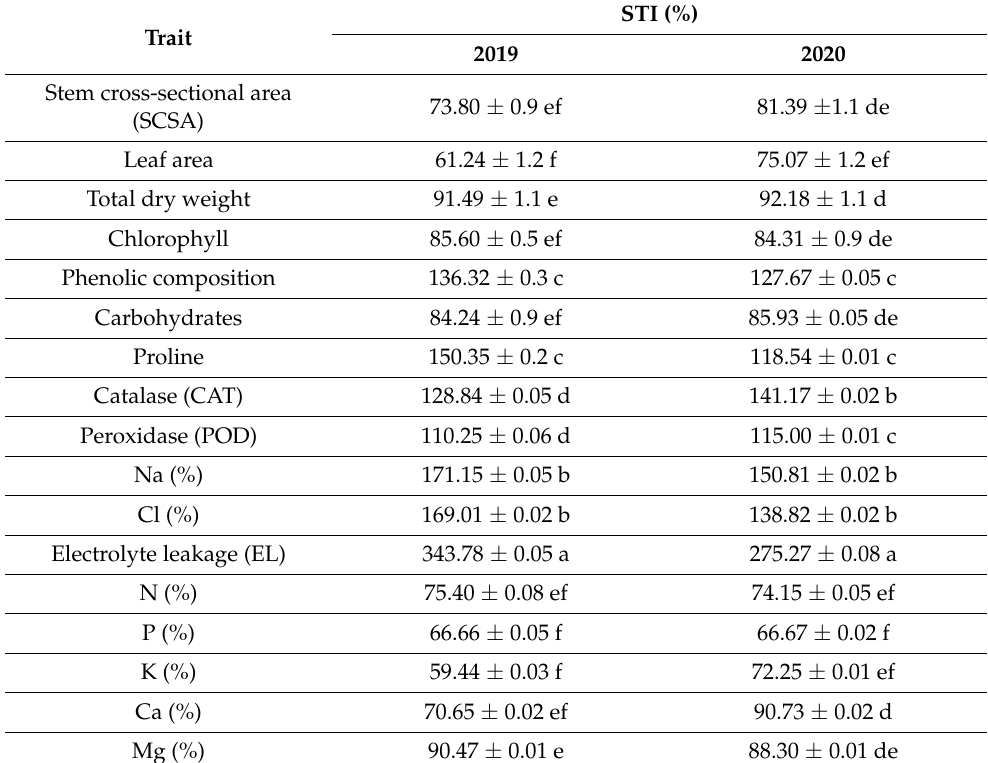
Table 6. Salt tolerance index (STI) of all the studied traits of pomegranate cv. “Wonderful” during 2019 and 2020 seasons.